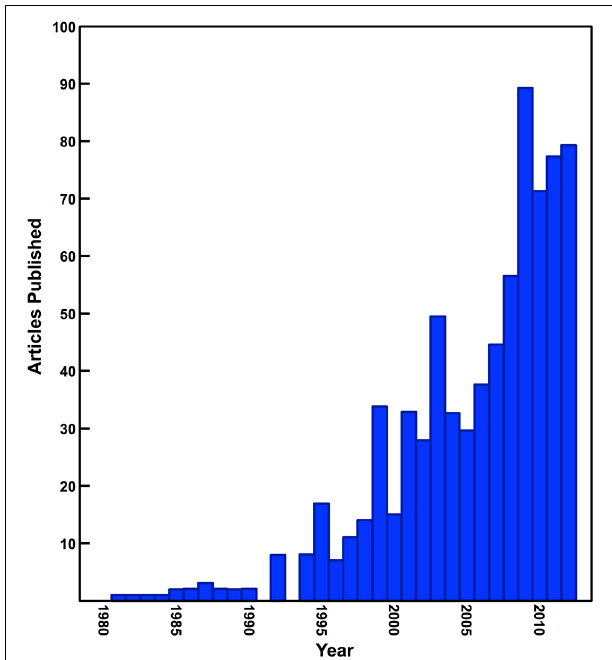
FIGURE 1 | Number of papers published in archaeology and anthropology journals utilizing isotope ratio mass spectrometry. Data presented in this figure were generated using a simple keyword search of archaeology and anthropology journals indexed by